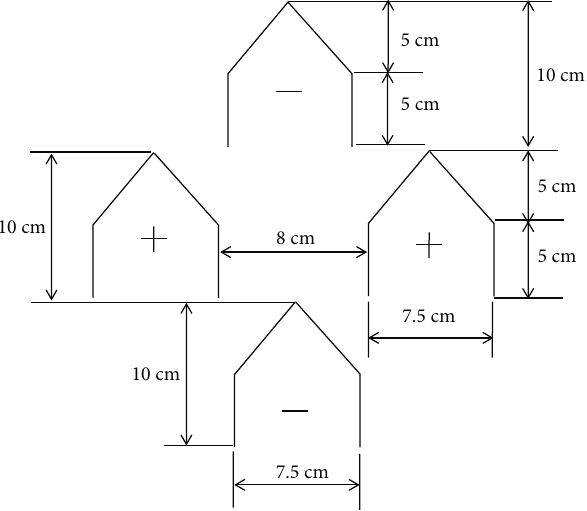
Figure 6: Schematic of the air ducts with